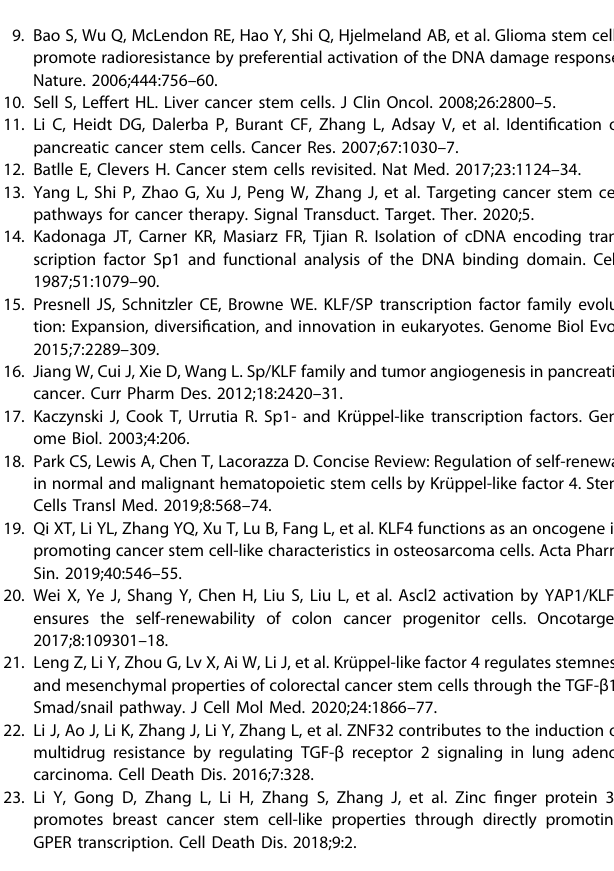
Fig. 6 The ZNF32-LEPR signal was negatively correlated with the survival of CRC patients. ( A , B ) IHC was used to analyze the expression of ZNF32 in tumor tissue (CRC) and adjacent normal tissue (AN). The positive cells were stained brown. The image is one represent of three independent experiments. (micron bar = 200 μ m). ( C , D ) IHC to analyze the expression of LEPR in CRC and AN. The positive cells were stained brown. The image is one represent of three independent experiments. (micron bar = 50 μ m). ( E ) Correlation analysis demonstrated that ZNF32 expression was positively correlated with LEPR expression in CRC tissues. ( F ) The survival status of patents was followed up, and Kaplan – Meier survival curves for these 100 patients were categorized into two groups based on the ZNF32 IHC score. ( G ) Kaplan – Meier survival curve for 78 patients (36 with high and 42 with low ZNF32 expression) who had received different cycles of chemotherapy (platinum combined with fl uorouracil). Each experiment was performed at least in triplicate, and consistent results were obtained. The data presented here are from one representative experiment of three independent experiments and are presented as the means ±